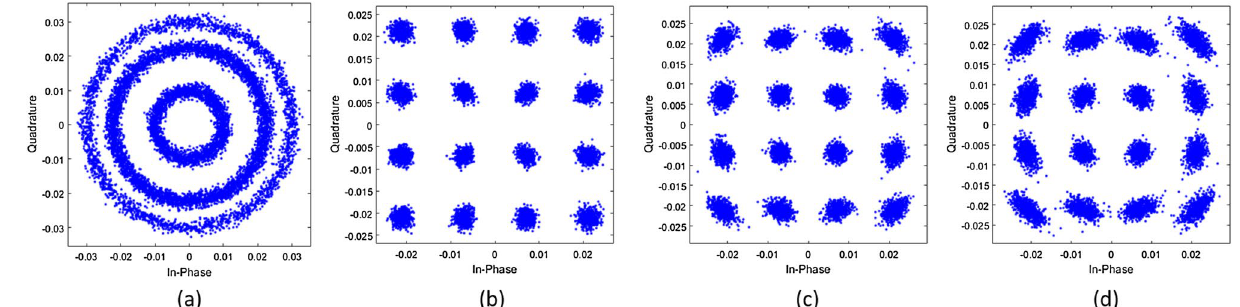
x -polarisation before and after 2 state MKF at Pin = ˆ